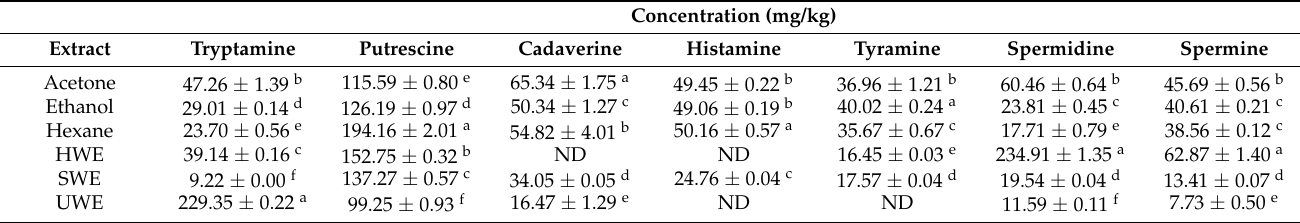
Table 3. Determination of seven biogenic amines in wheat germ extracts by reversed-phase high-performance liquid chromatography.